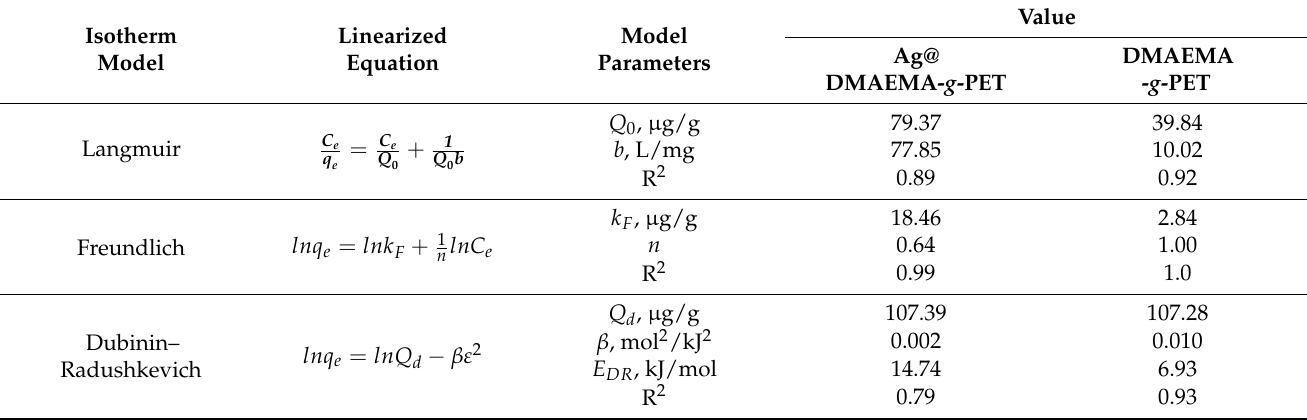
Table 2. Parameters calculated from various isotherm models (initial As(III) concentration: 50 ppm, pH: